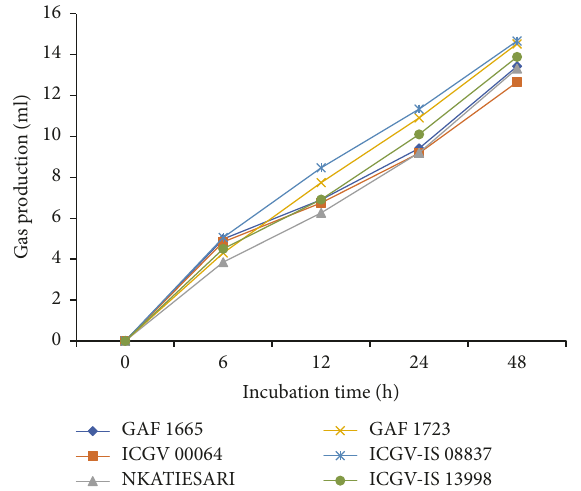
Figure 1: In vitro gas production rate of dual purpose groundnut haulms fermented with rumen fluid at different time